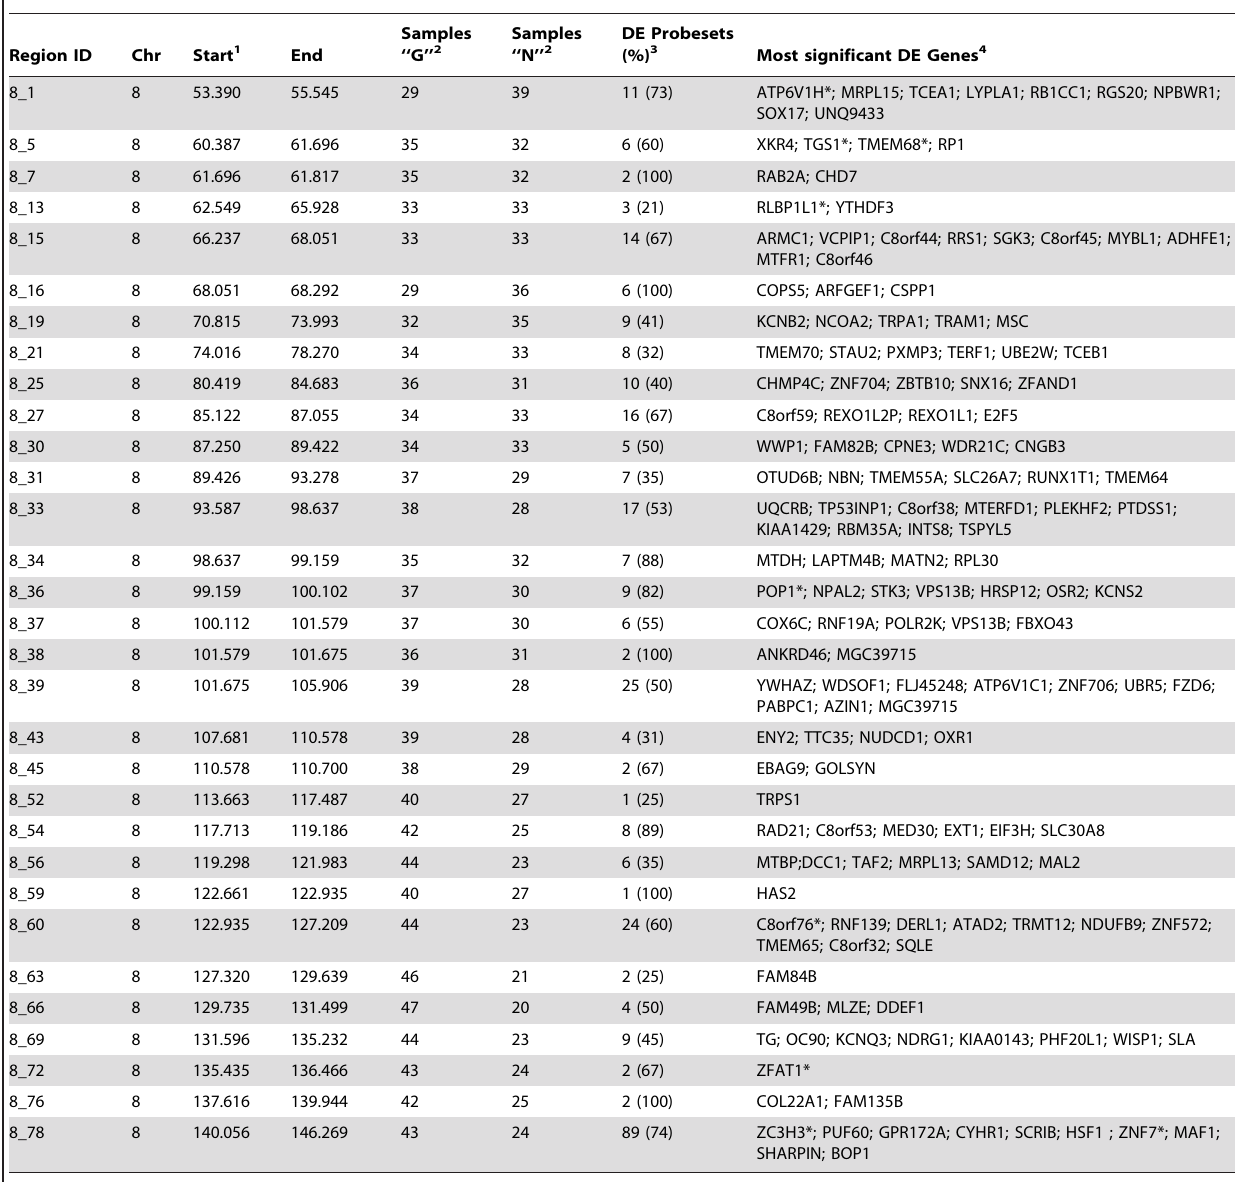
Table 3. Genes with increased expression on chromosome